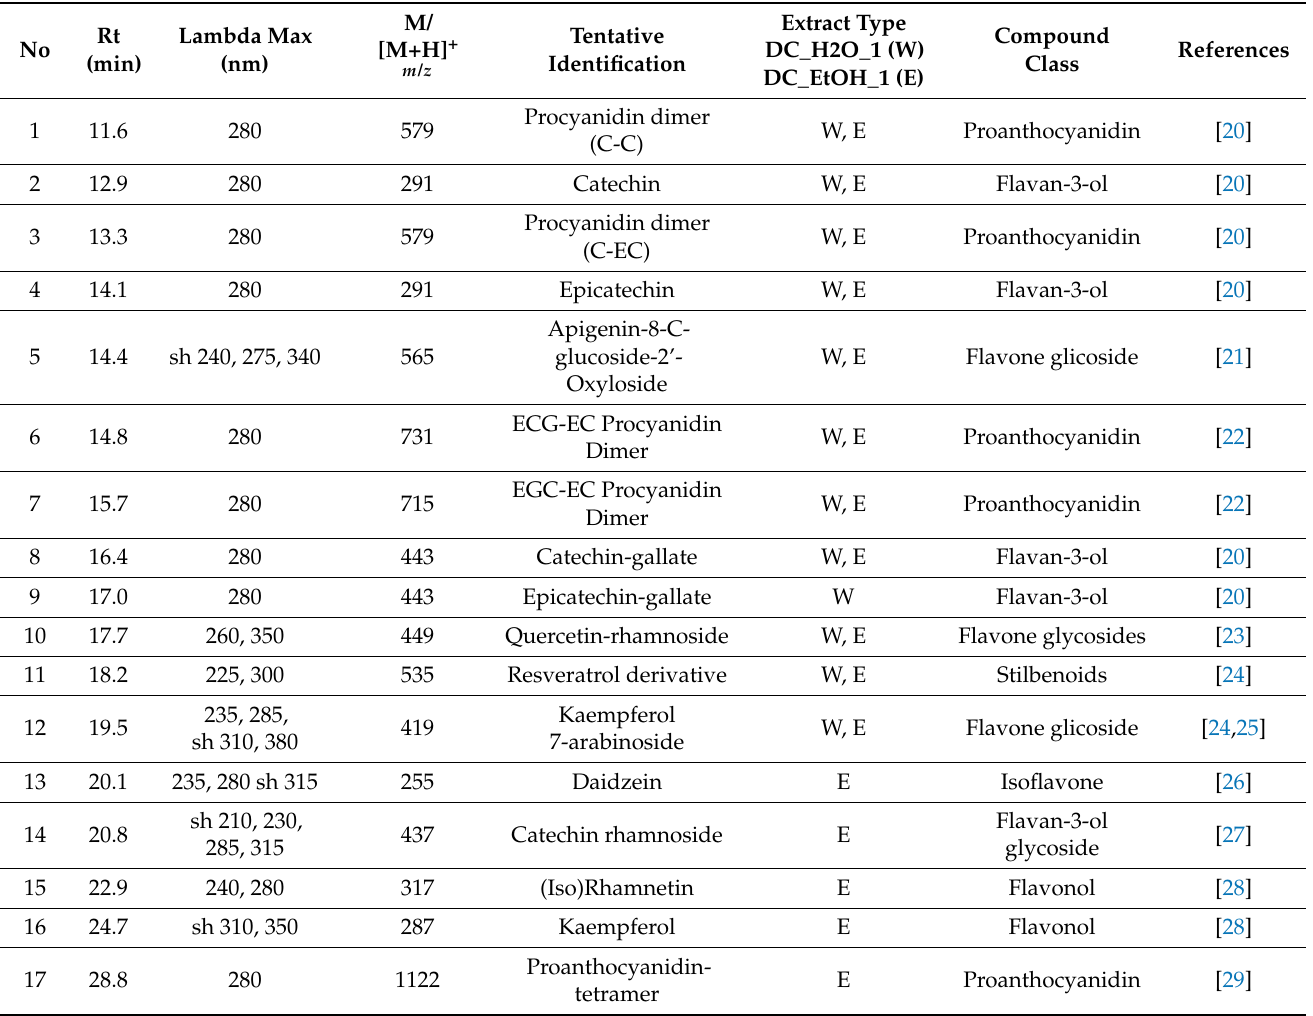
Table 2. Liquid Chromatography–Diode Array Detection–Electro-Spray Ionization Mass